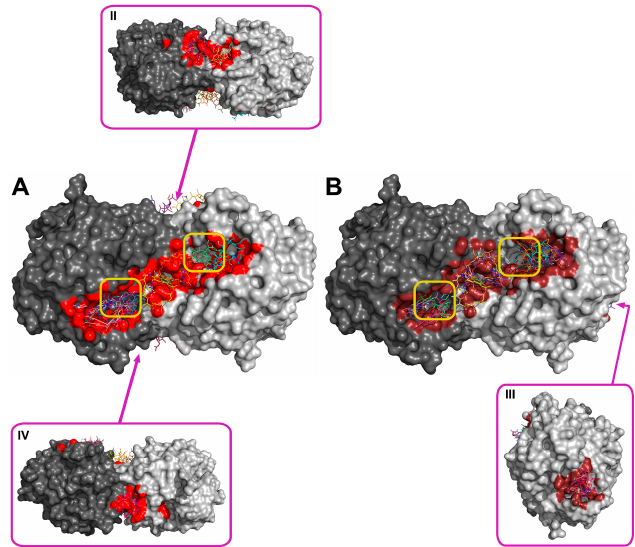
Figure 5. Supposed localization of the domains for binding rifampicin at pH 7.5 ( A ) and 10.5 ( B ). The two subunits of the His 6 ‐ OPH homodimer are colored differently (grey and dark grey). Atoms on the surface of His 6 ‐ OPH located within 4 Å of any atom of rifampicin, as well as the corresponding molecular surface, are colored red ( A ) or ruby ( B ), respectively. Entrances to the active sites of the His 6 -OPH dimer are highlighted with yellow boxes. Magenta boxes show clockwise a His 6 -OPH dimer molecule when it is viewed from above (II), from the right (III), and from below (IV) (relative to the side where the active sites are